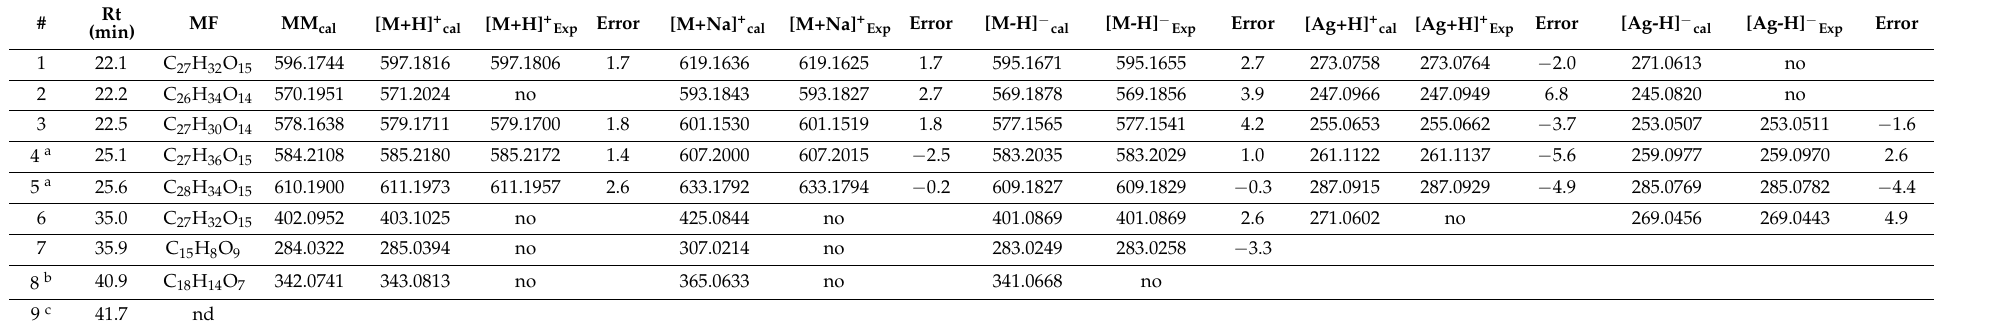
Table 2. High-resolution MS data from the photoactive